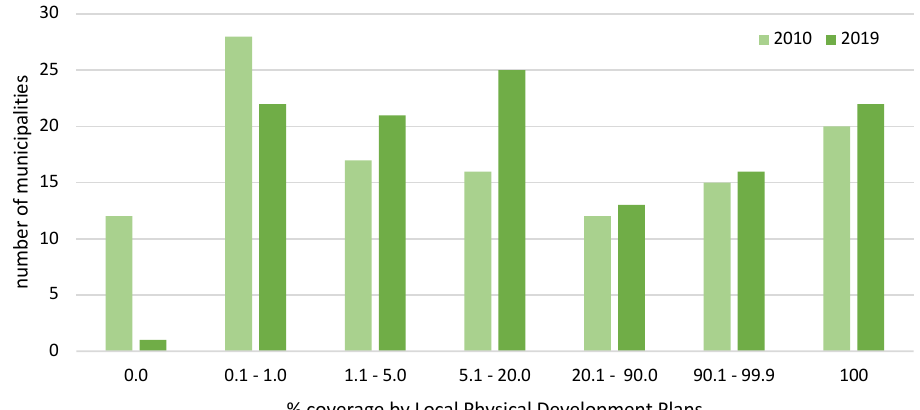
Figure 3. The change in planning coverage noted in rural gminas of the Łód´z voivodeship between 2010 and 2019 inclusive. Source: based on data from Statistics Poland